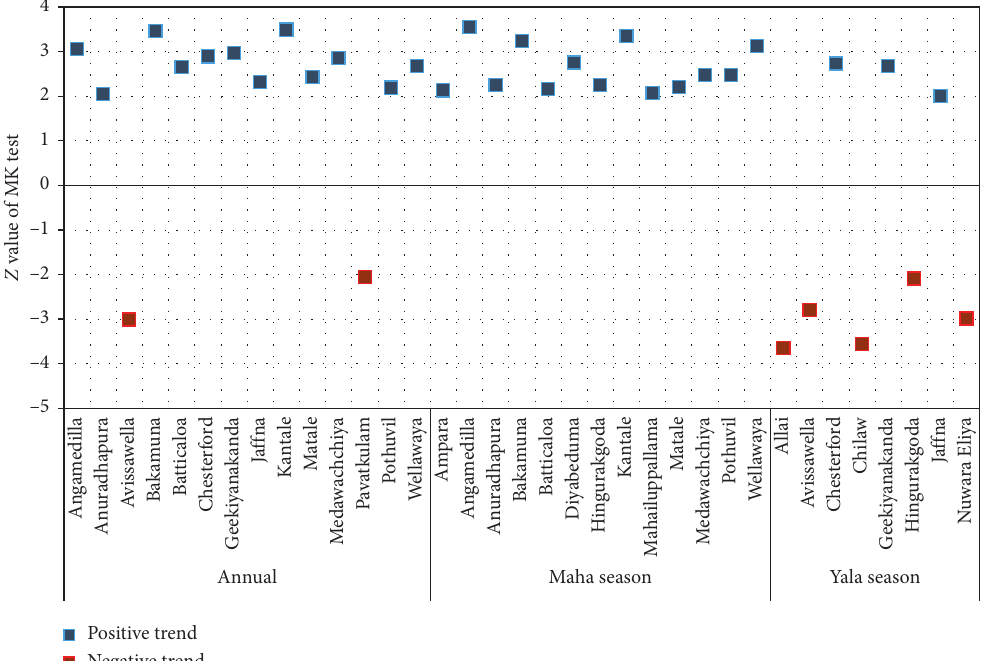
Figure 6: Summarized results of the MK test for SPI12 (Annual) and SPI6 ( Maha and Yala seasons). Stations showing a significant trend at 0.05 level of significance are only